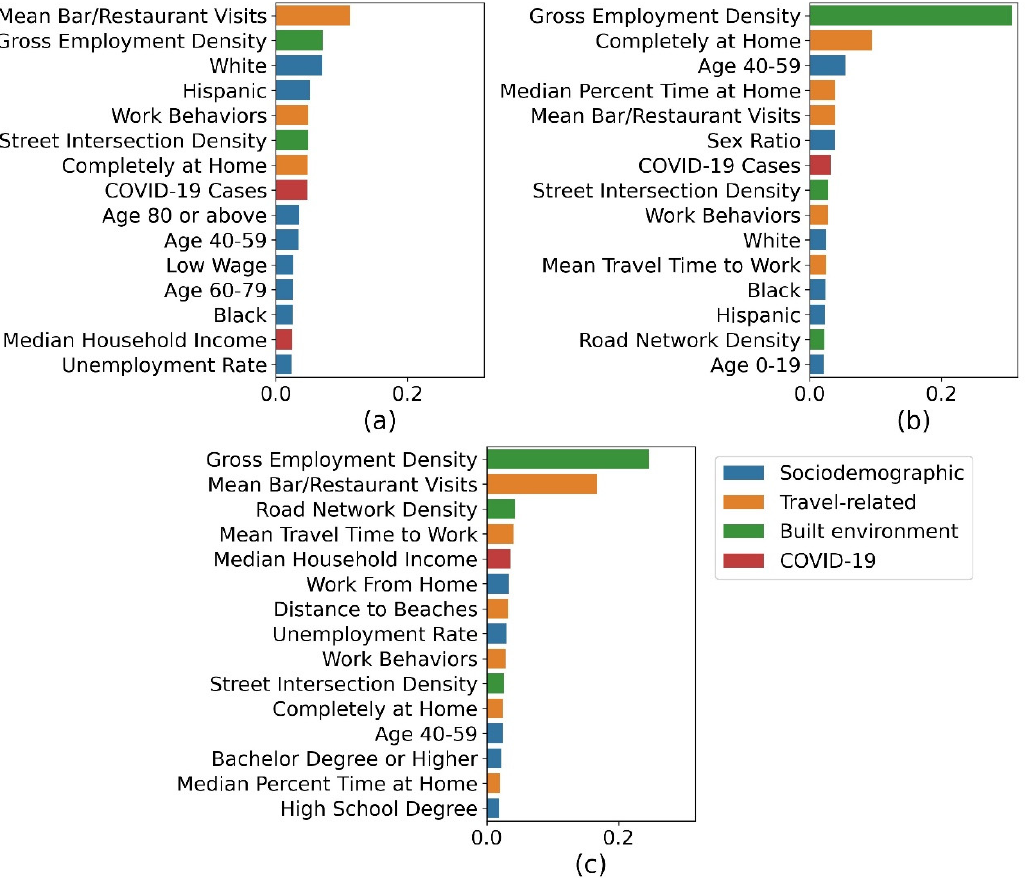
Figure 5. The relative importance of the top 15 variables to the number of inflow trips per person (05/01–06/15/2020) using random forest models for ( a ) Miami-Dade County, ( b ) Broward County, and ( c ) Palm Beach County.